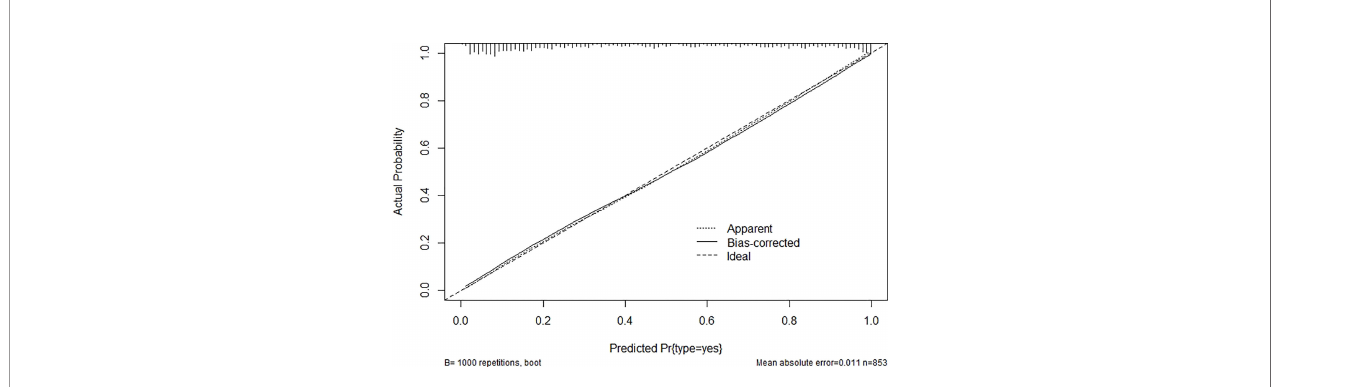
FIGURE 2 | Area under ROC curve (concordance index) (A) in the training cohort and (B) in the validation cohort. ROC, receiver operating